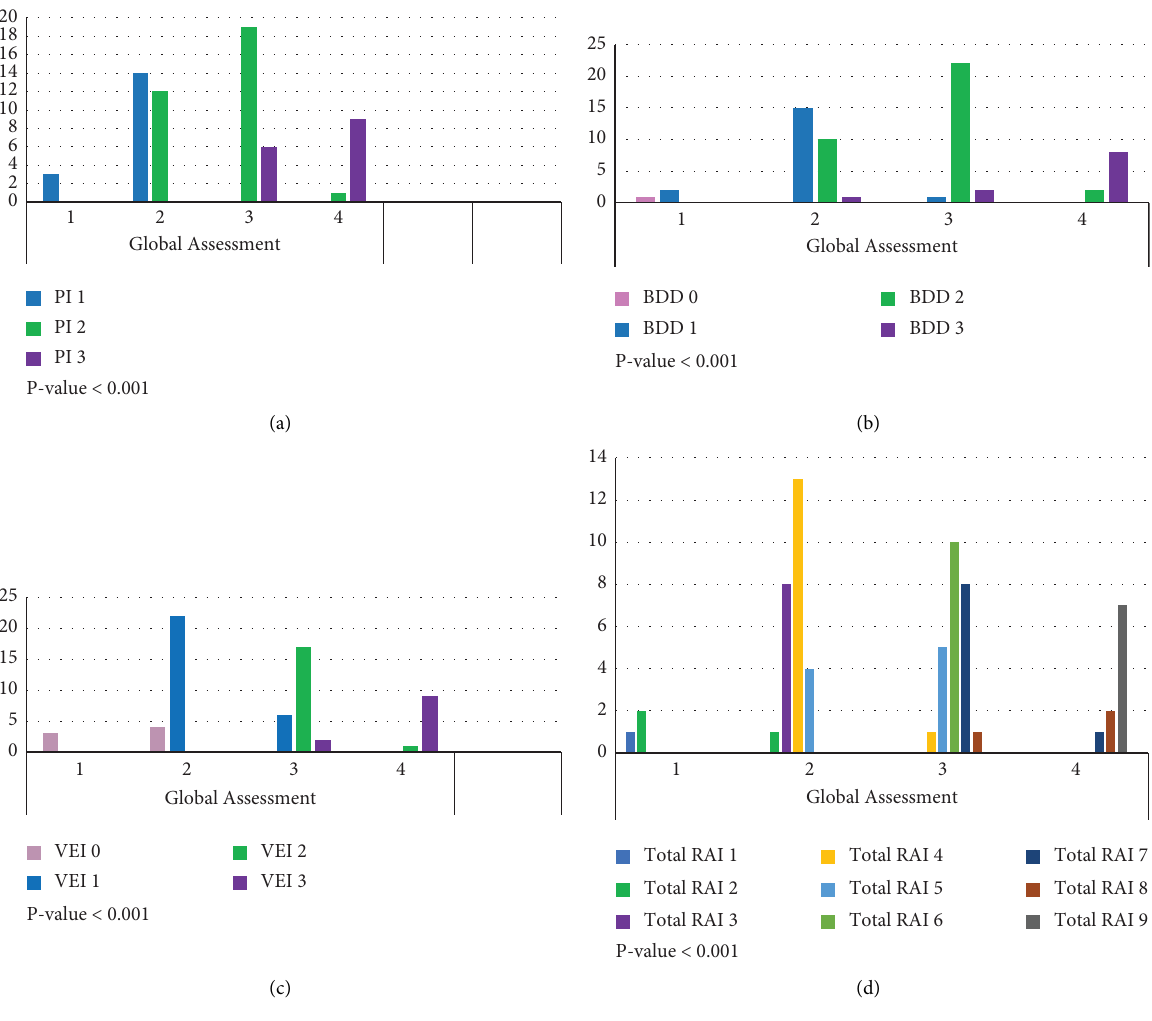
Figure 1: Clustered bar count of global assessment by (a) portal infammation (PI); (b) bile duct damage (BDD); (c) venous endothelial infammation (VEI); and (d) total rejection activity index (RAI) categories for T-cell mediated rejection biopsy. P values indicate the Fisher–Freeman–Halton correlations between global assessment and PI, BDD, VEI, and total score. Global assessment values:1 corresponds to the intermediate category; 2 to mild; 3 to moderate; and 4 to